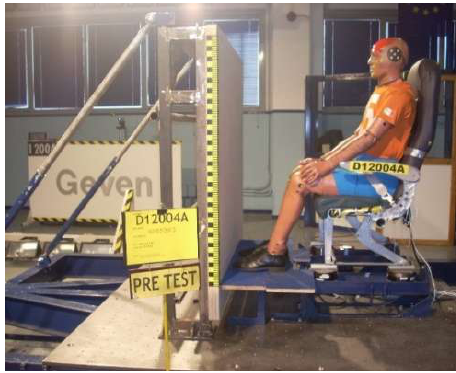
Figure 2. Full-scale sled test setup.